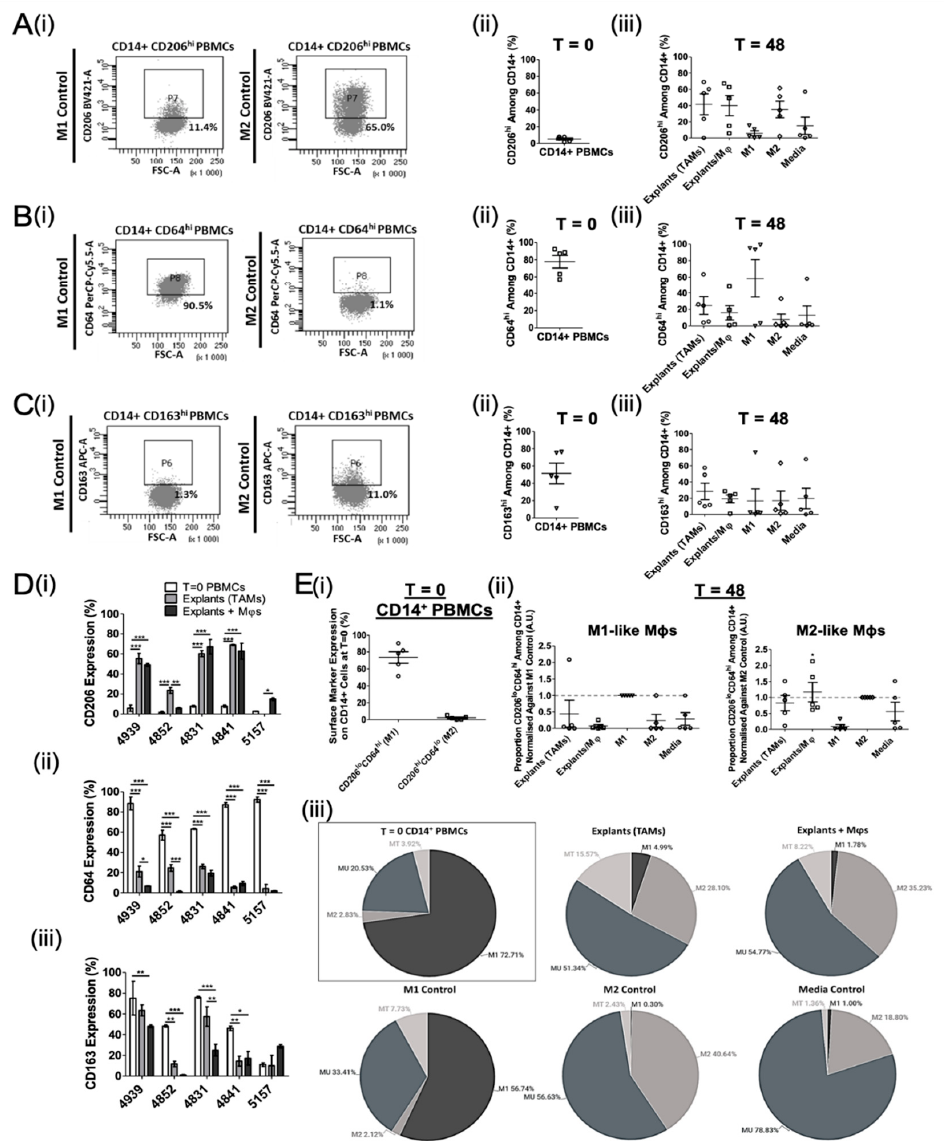
Figure 2. NSCLC explants promote M1- to M2-like M φ polarisation ex vivo. Tumour explants were co-cultured with autologous patient CD14 + PBMCs for 48 h to enable macrophage polarisation. CD14 + cells were polarised into M1 or M2 M φ controls, as described, or incubated without cytokines (unpolarised media controls). Explant only wells were setup to